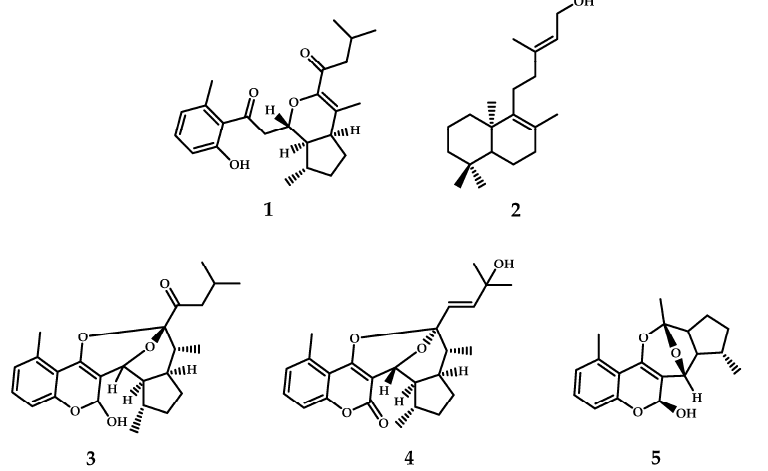
Figure 1. Compounds subjected to docking assays into the corresponding catalytic sites of acetylcholinesterase, butyrylcholinesterase, and tyrosinase: 2- nor -1,2-secolycoserone (( 1 ), peak 26, Table 1), ent -labda-8,13- E -diene-15-ol ( 2 ), cyclolycoserone (( 3 ), Peak 20, Table 1), 8- epi -gypothamniol (( 4 ), peak 16, Table 1), 6-Hydroxyaphyllodenticulide (( 5 ), peak 5, Table